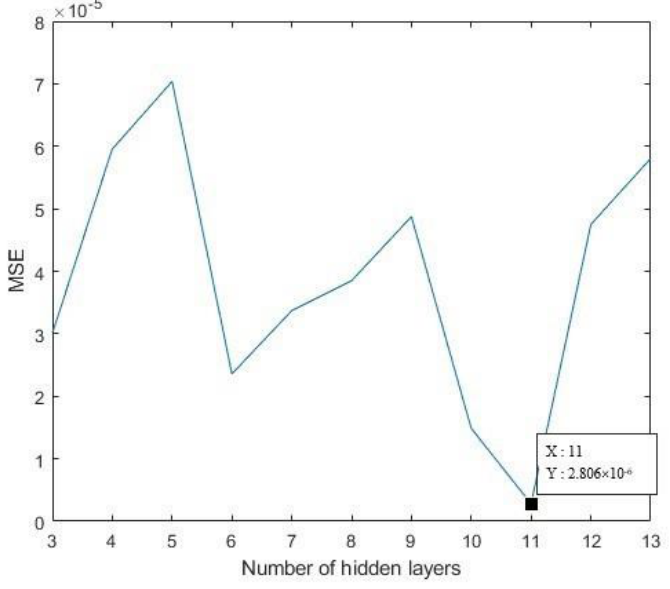
Figure 5. Optimal hidden layer node graph.